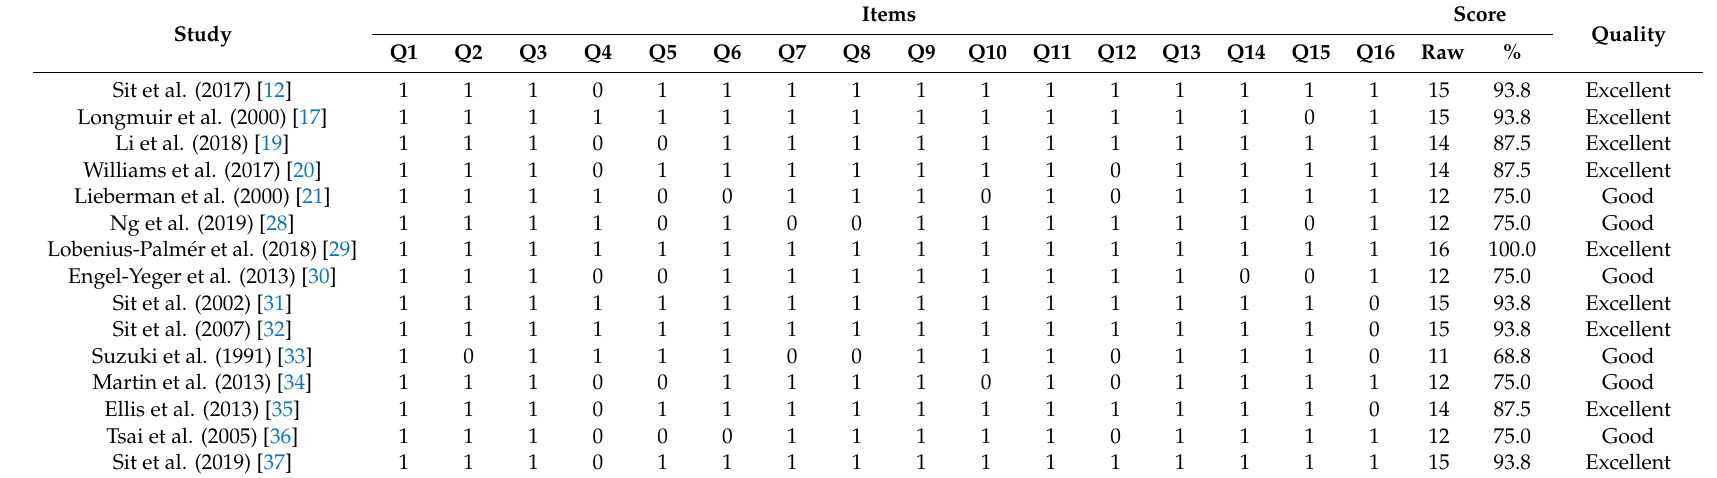
Table 1. Results of study quality evaluation using the adapted McMaster Critical Review Form for Quantitative